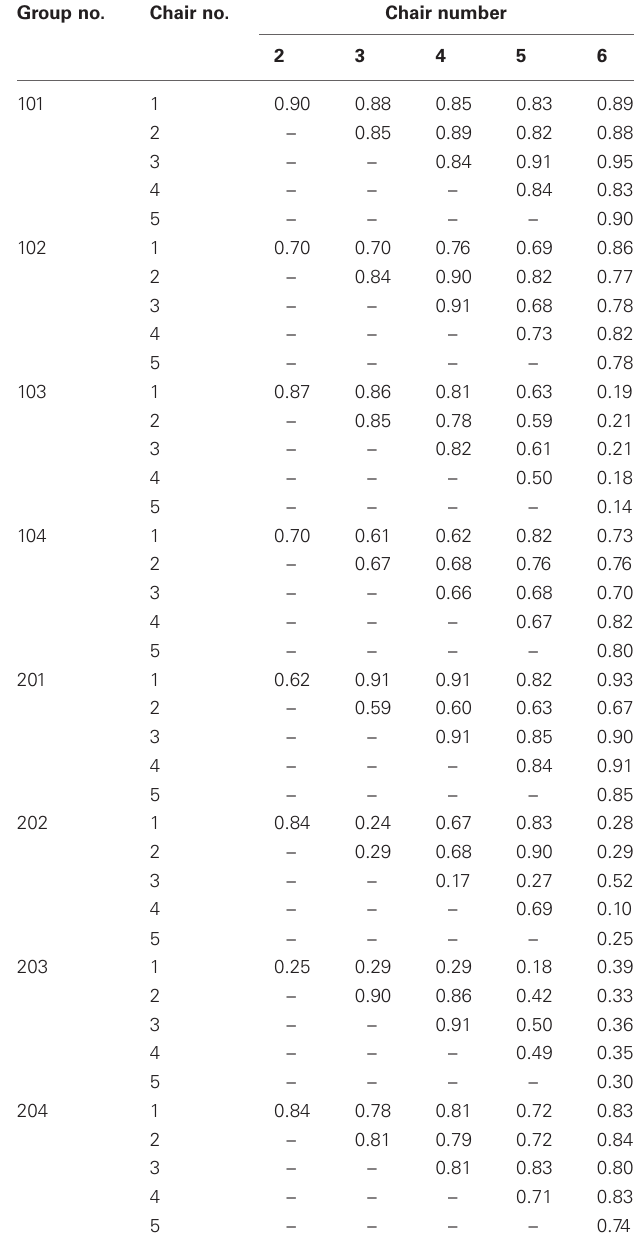
Table 3 | Dyadic, ρ Dyad , Cluster